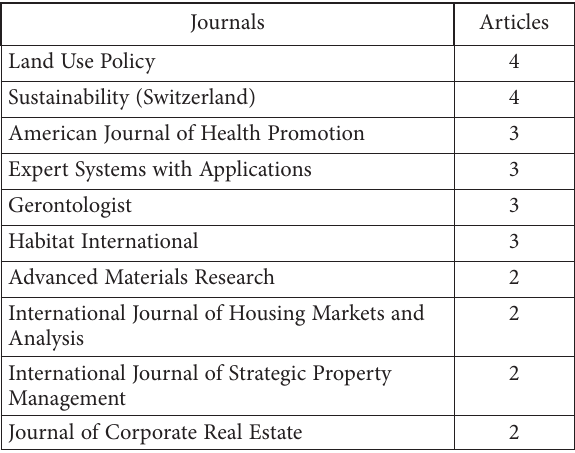
Table 4. Influential journals publishing articles in the field of